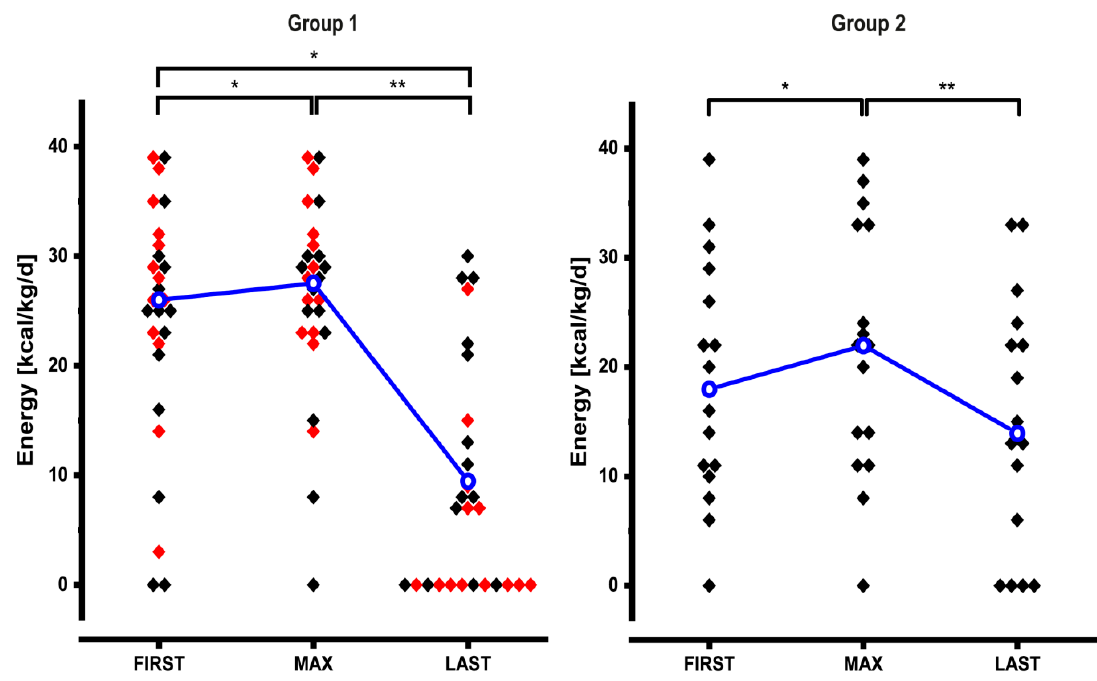
Figure 2. Dynamic changes of energy support in group 1 and group 2 patients. In group 1, 11 patients had reconstructive surgery and 2 patients received teduglutide between MAX and LAST, they are indicated as red symbols and they are not included in the statistical analysis (median values and significant differences) at time point LAST. Median values are connected by the blue line. See text for details (* p < 0.05; ** p < 0.01).